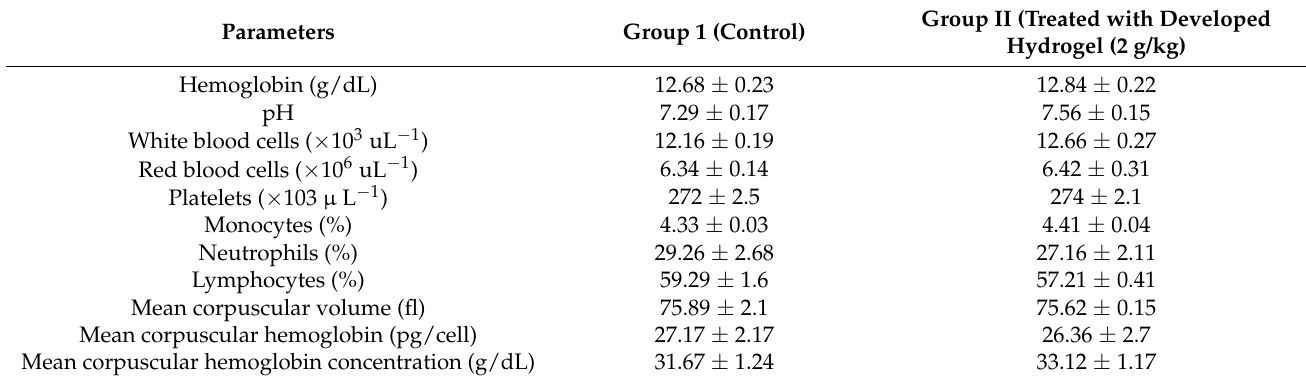
Table 3. Results of hematological analysis of rabbits’ blood.